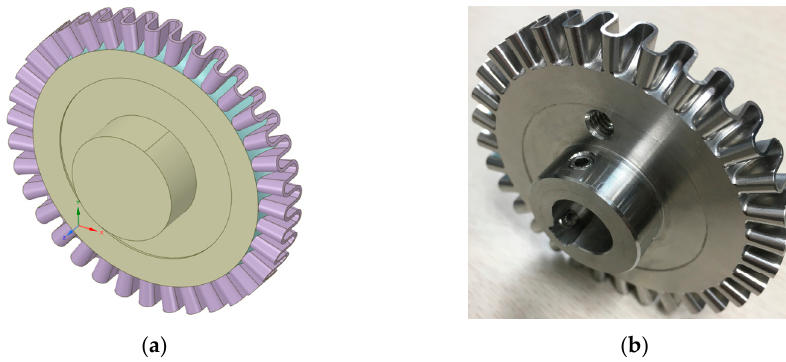
Figure 12. Optimal design of ‘S-shape’ impeller: ( a ) solid modeling; ( b ) manufactured impeller.